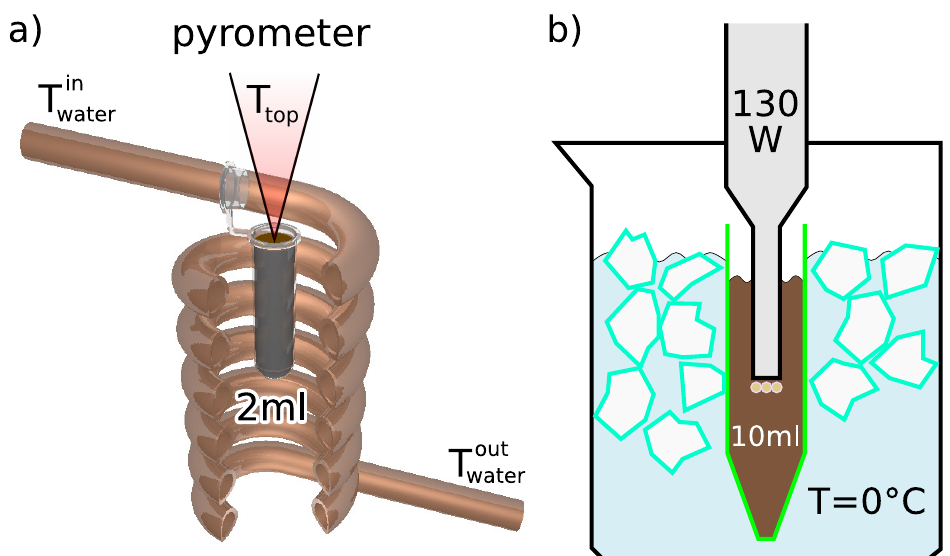
Figure 1. ( a ) The schematic drawing of the induction heating set, where the temperature is different ∆ T = T in between the top layer of the aqueous solution (measured with a pyrometer) and top − T water the water entering the cooling system. ( b ) Diagram of our ultrasonic probe placed in a vial with a colloidal suspension. Thanks to the ice-water bath, the temperature of the sonicated suspension never exceeds 20 ◦ C during the sonication process. After transferring the volume of 2 mL of suspension from the vial to the Eppendorf tube, its temperature was equalized with the temperature of water T in entering the coil (typically around 17 ◦ water